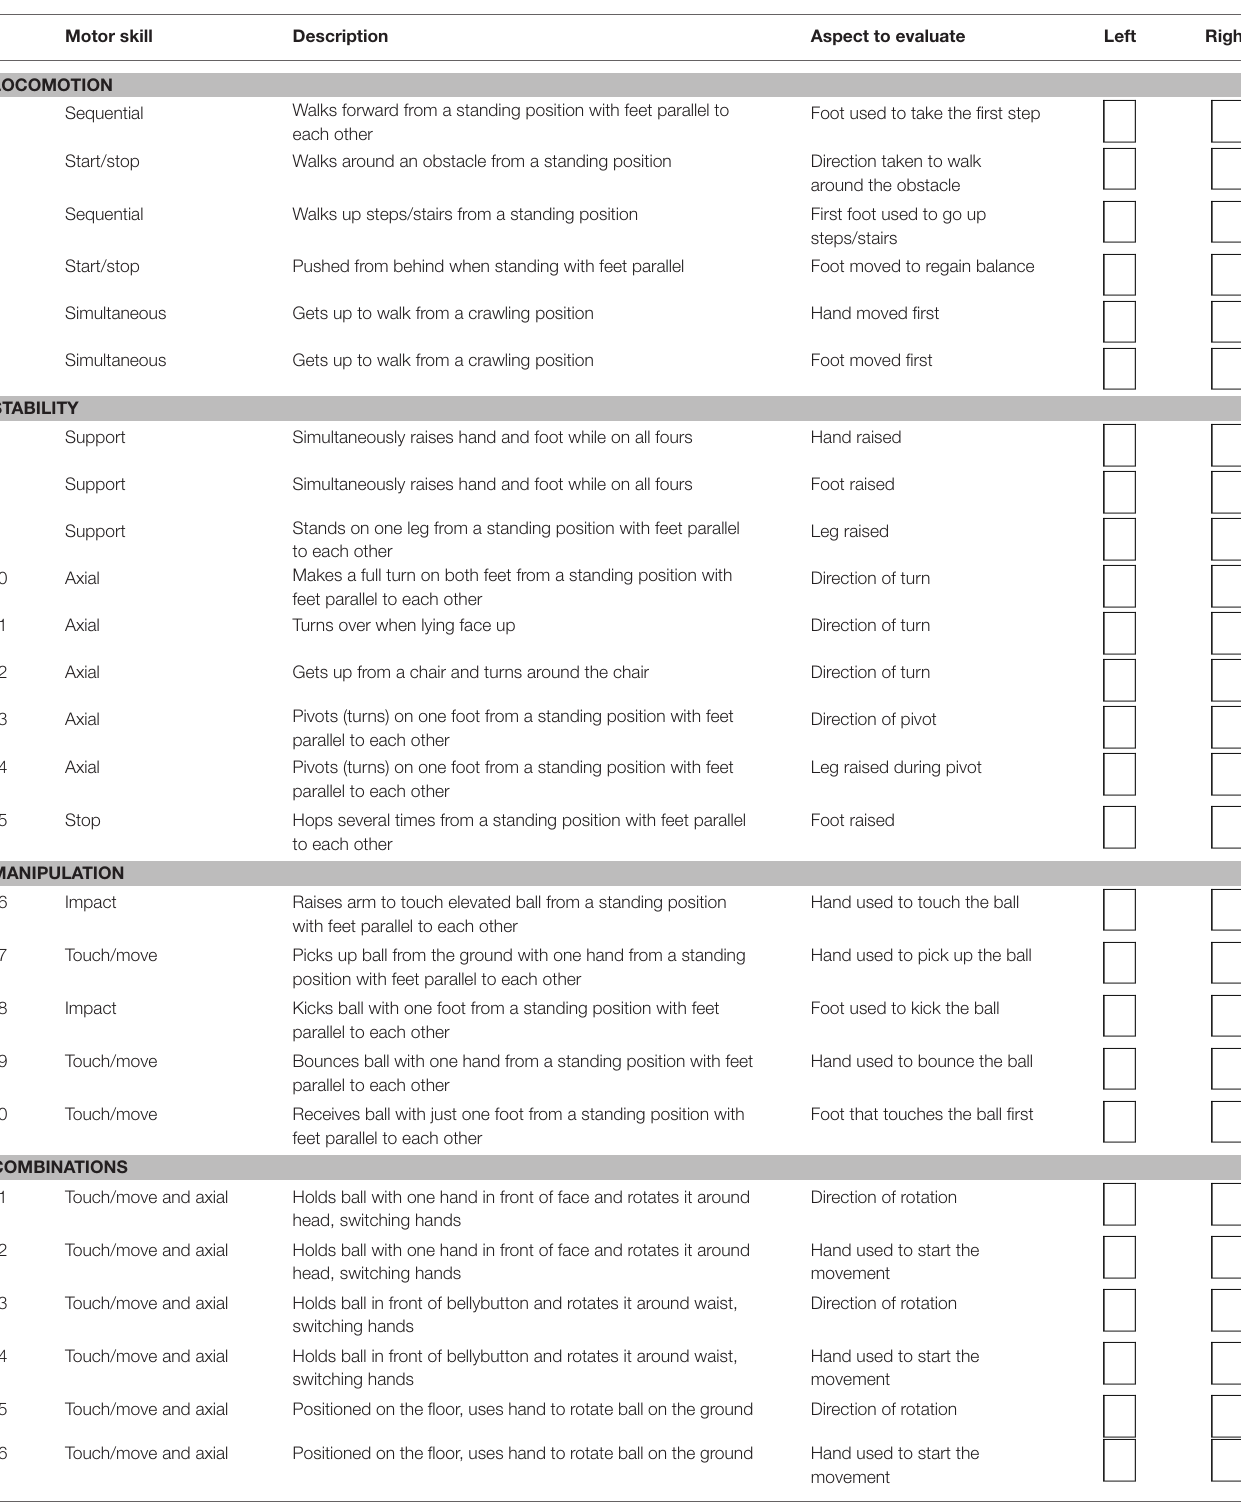
TABLE 1 | MOTORLAT motor laterality inventory. Motor